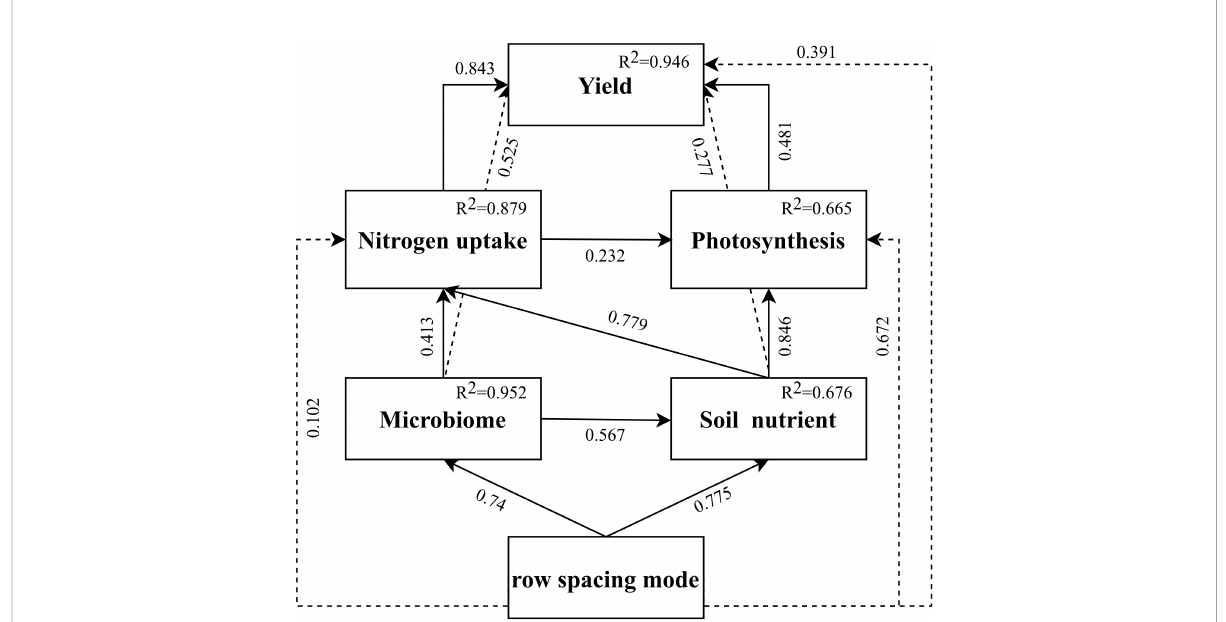
FIGURE 4 The path analysis correlation coef fi cient among of row spacing mode, microbiome, soil nutrient, nitrogen uptake, photosynthesis and yield. The solid and dotted lines are direct and indirect effects. Numbers next the arrow line indicate correlation. The ratio of interpretation variance (R2) appears in the upper right of each indicator in the